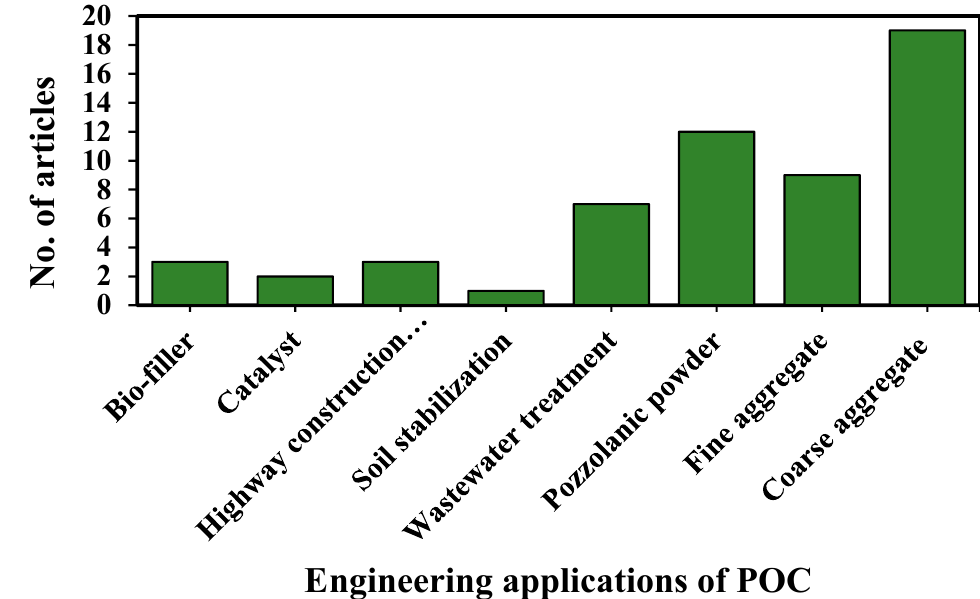
Figure 8. Articles published with various POC applications.